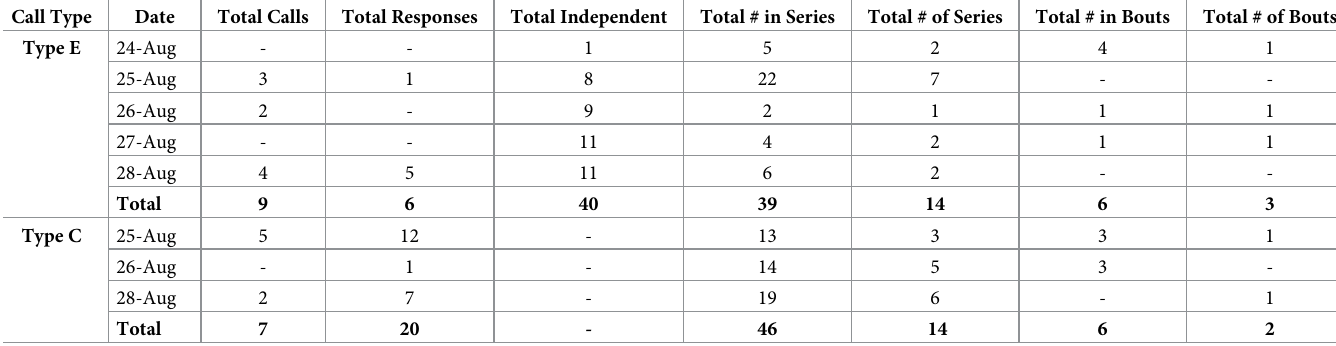
Table 2. Occurrence of type E and C emissions within each vocal event type.